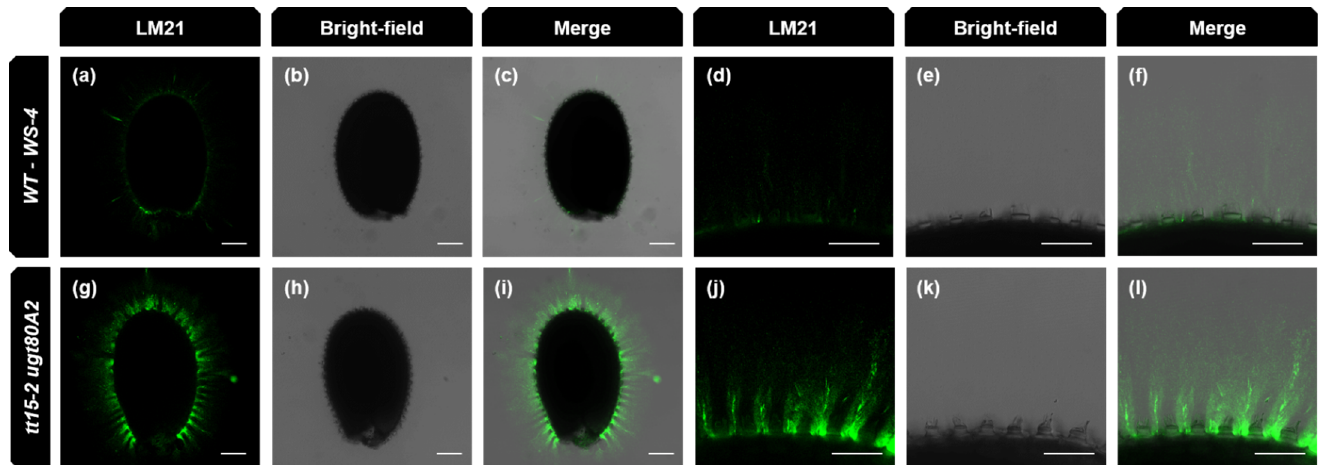
Figure 9. Immunolabeling of inner mucilage heteromannan epitopes is more intense in the double mutant tt15-2 ugt80A2 than in wild type. Confocal microscopy optical sections of mature seeds and the inner mucilage layer after labeling of heteromannan with LM21 antibodies (green). ( a , d , g , j ) show LM21 labeling alone, ( b , e , h , k ) are bright-field images and ( c , f , i , l ) are composite image of labeling and bright-field. ( a – c ) and ( g – j ) show whole seeds, and ( d – f ) and ( j – l ) are higher magnifications of a zone from the corresponding whole seed image. WT, wild type. Bars = 100 µm ( a – c ) and ( g – j ) and 50 µm ( d – f ) and ( j – l ).